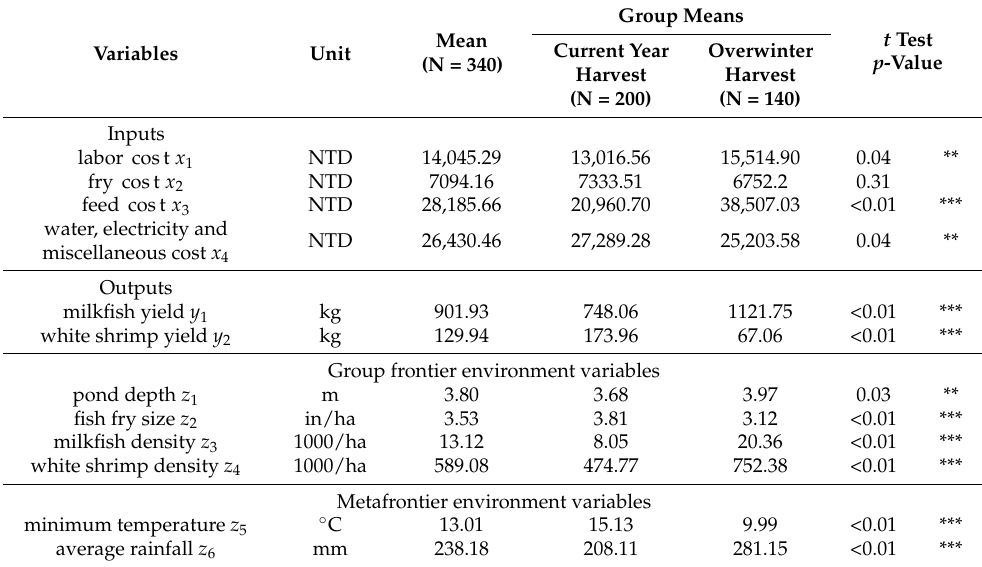
Table 1. Descriptive statistics on inputs, outputs and environment variables and t test. on the difference between